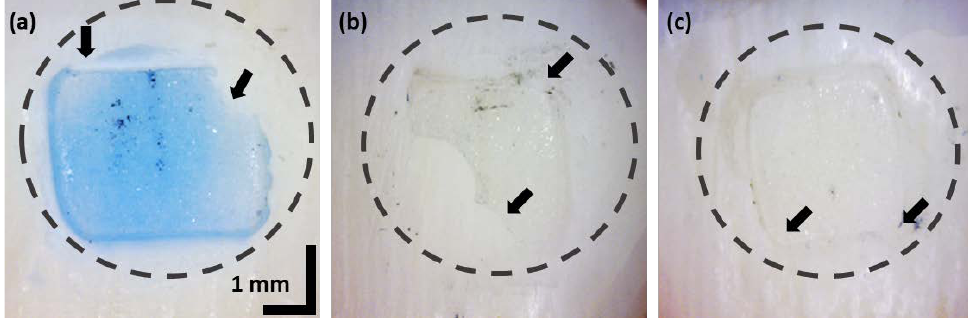
Figure 1. Optical microscope images of samples: ( a ) Sample A with blue color adhesive; ( b , c ) Sample B, sample C with transparent adhesive. Black color solid arrows indicate the residual boundaries.